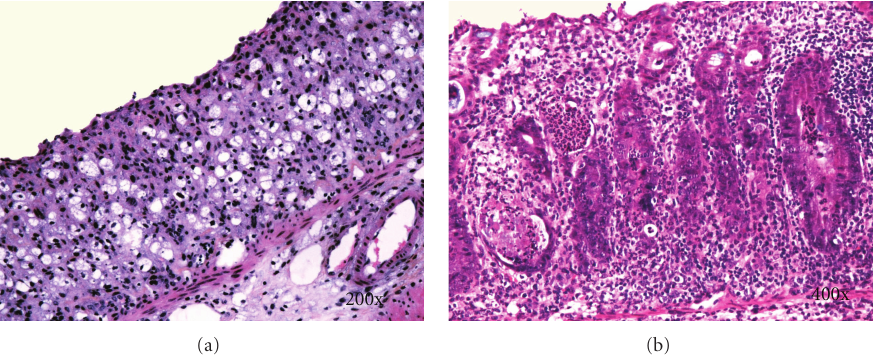
Figure 3: (a) Vacuolar hydropic degeneration of cells. (b) Epithelial necrosis, cryptitis, and crypt abscesses. Kreyberg trichrom stain (acid mucopolysaccharides are stained blue). C57BL/6JOlaHsd female mice exposed to 3% DSS solution for 5 days followed by drinking water for 21